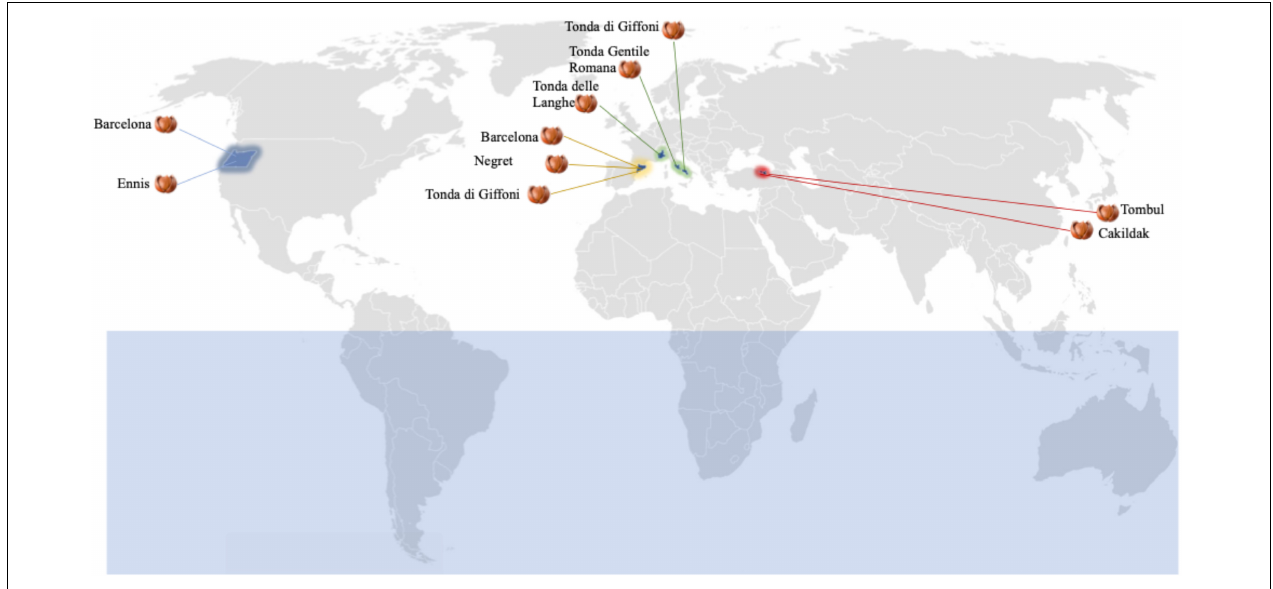
FIGURE 1 | Dried hazelnut lots from different boreal hemisphere areas: 10 Barcelona lots from Catalunya, Spain (five) and Oregon, United States (five); five Cakildak lots from Ordu, Turkey; five Ennis lots from Oregon, United States; five Negret lots from Catalunya, Spain; five Tombul lots from Giresum, Turkey; five Tonde delle Langhe lots from North Italy; five Tonda Gentile Romana lots from Central Italy; 10 Tonda di Giffoni lots from Southern Italy (five) and Catalunya, Spain